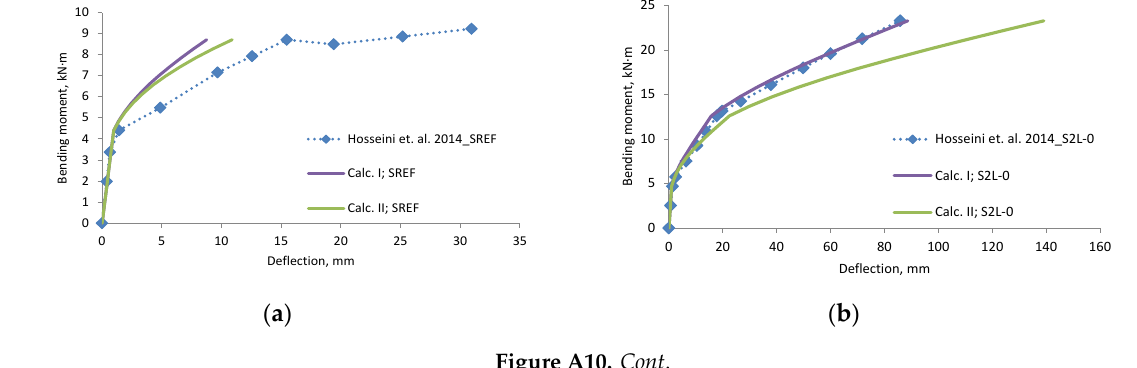
Figure A10. Cont